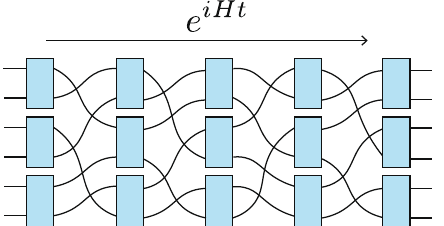
Fig. 2 Illustration of a circuit representing time evolution according to a k-local (in this case 2-local) Hamiltonian